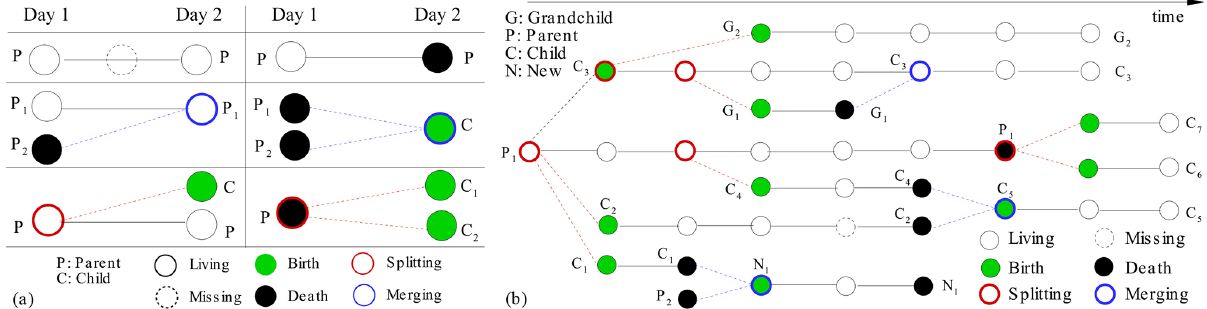
Figure 8. The logical genealogy of an ocean eddy with six states: birth, death, living, missing, splitting, and merging. (a) The logical relationships of eddies between 2 days. (b) The logical genealogy evolution model of an example